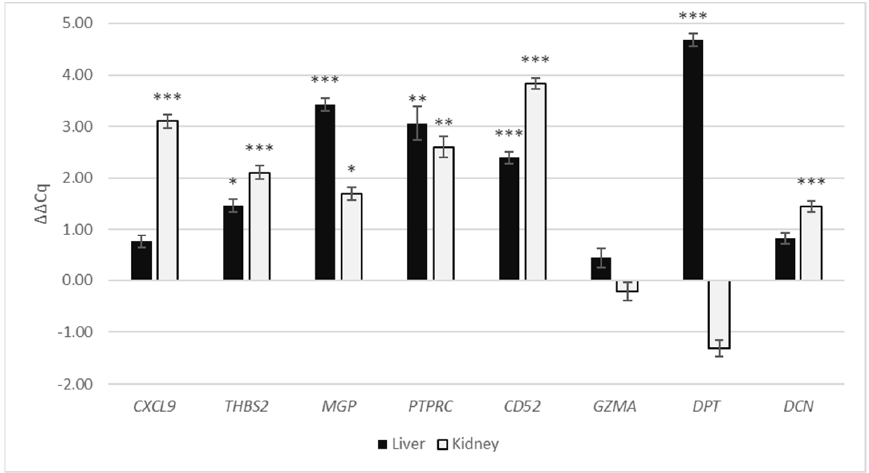
Figure 2. Gene expression of CXCL9, THBS2, MGP, PTPRC, CD52, GZMA, DPT and DCN in fibrotic kidney and liver expressed as ΔΔ Cq relative to normal kidney and liver, respectively. Legend: * p ≤